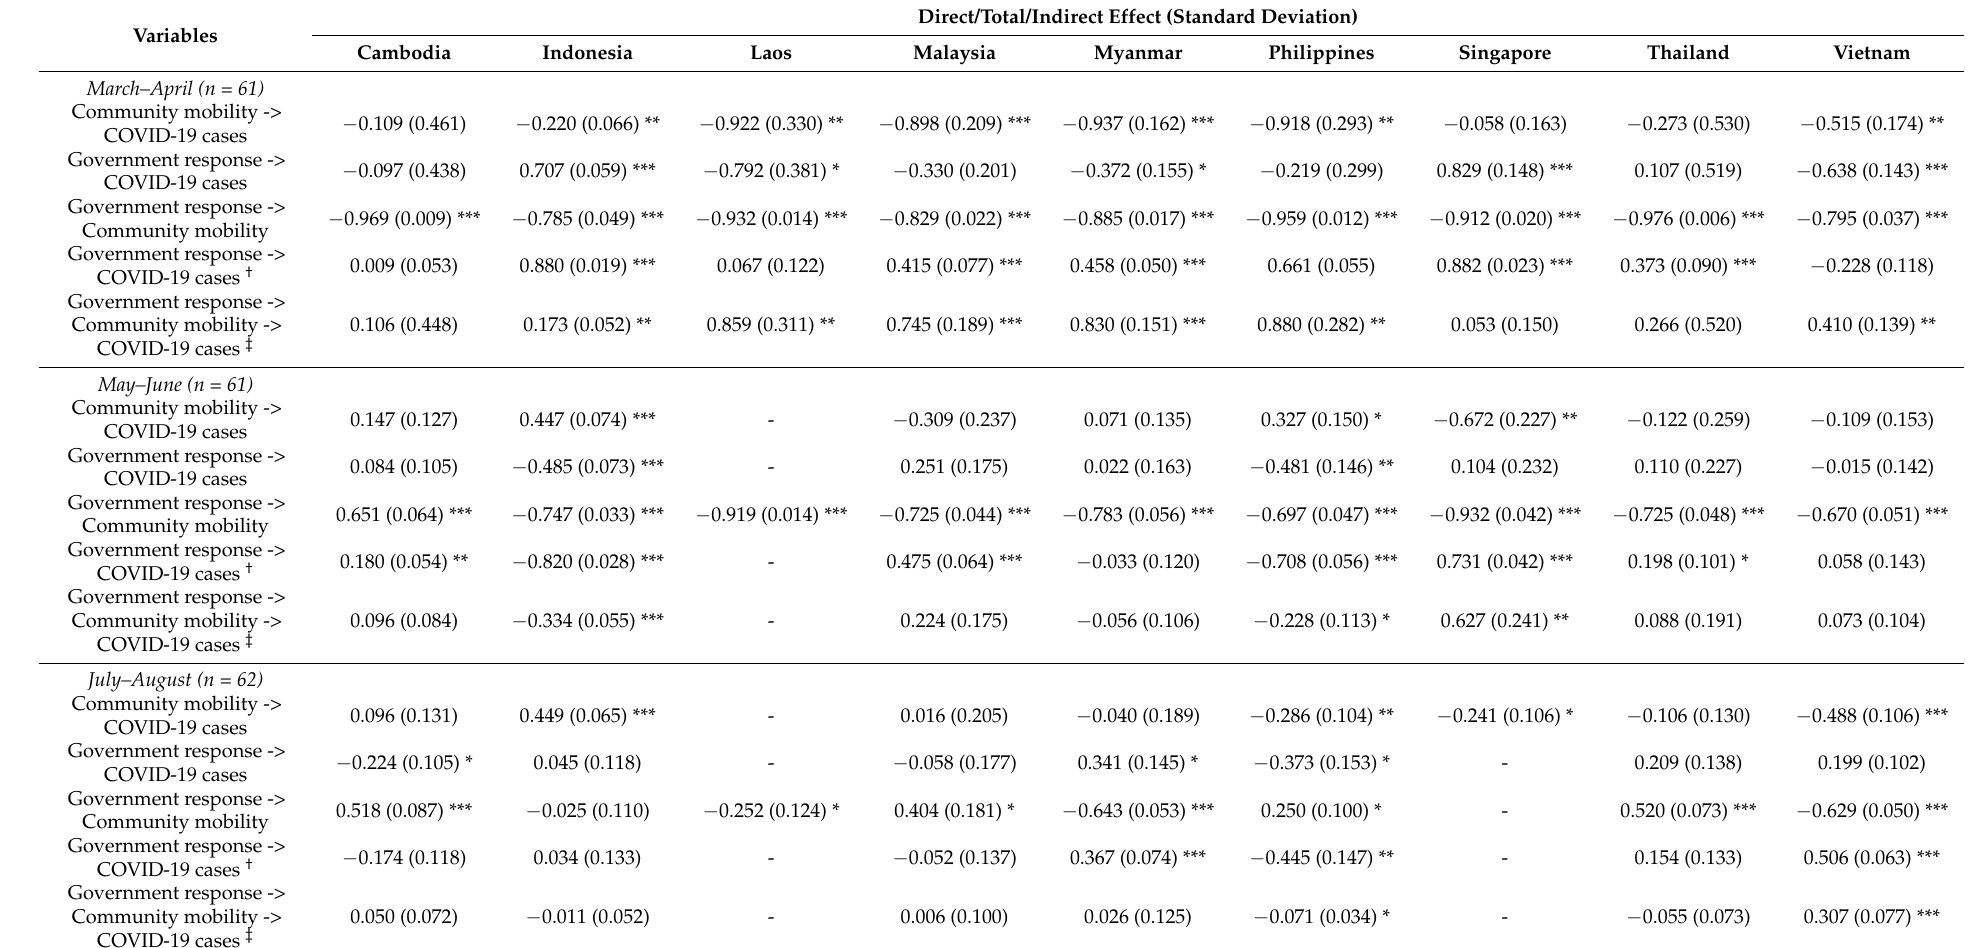
Table 2. Path coefficients of the government responses, community mobility, and COVID-19 cases in Southeast Asian countries.